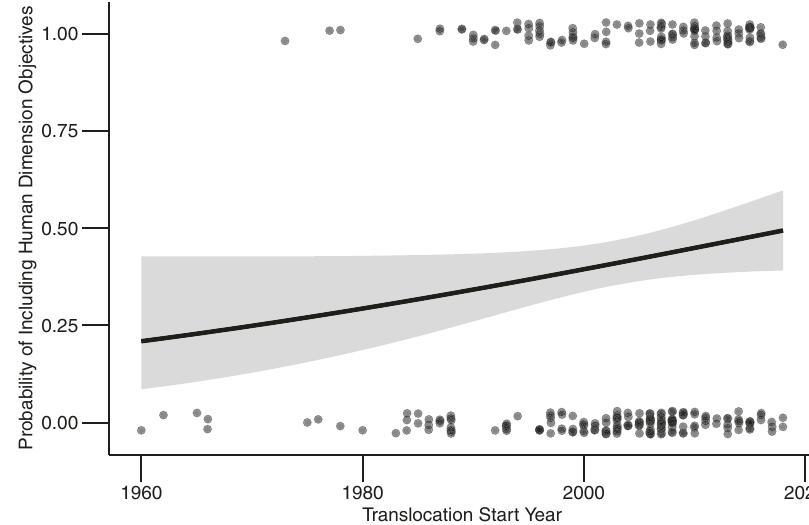
Fig. 3 | The inclusion of human dimension objectives has increased over time. The line indicates the predicted probability of including a human dimension objective in a wildlife translocation through time; the shaded area represents the 95% con fi dence interval, and the points indicate raw data (binary inclusion or